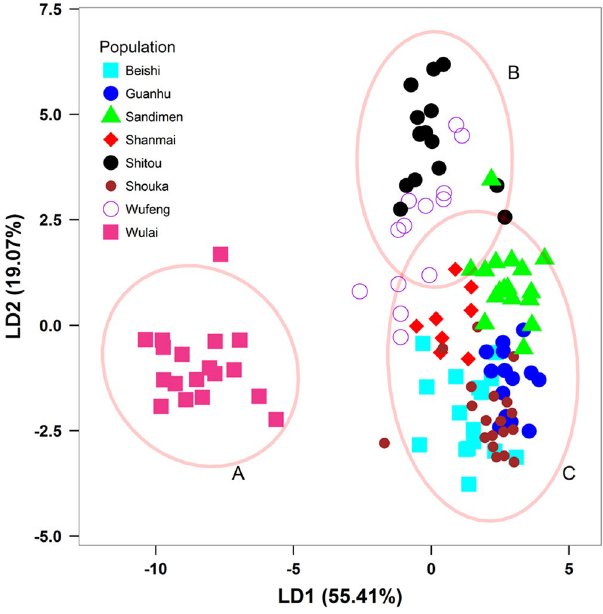
Figure 4. Scatter plot of the first two linear discriminants (LDs) from the discriminant analysis of principal components based on 521 amplified fragment length polymorphic loci for individuals of eight populations of Musa basjoo var. formosana . The ellipses represent 95% confidence intervals distinguishing the three genetic clusters A, B, and